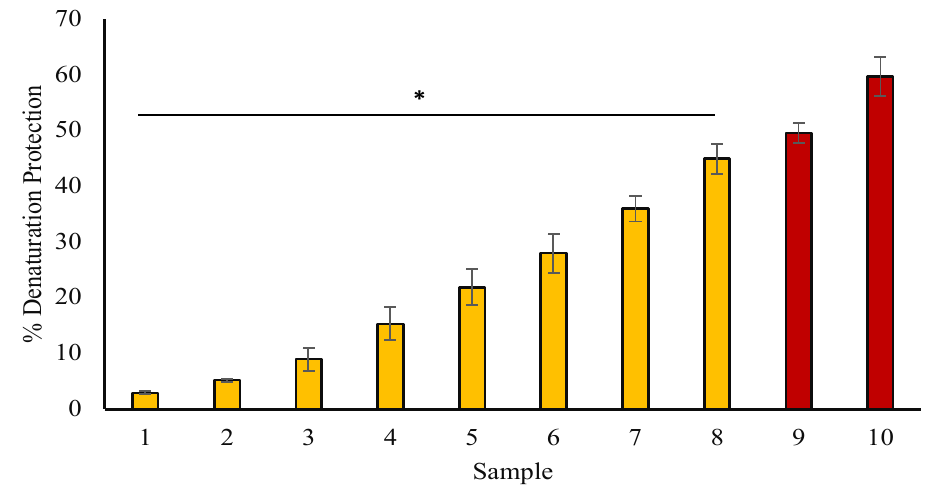
Figure 5. Egg albumin denaturation protection (%). Yellow columns (1–8) represent samples with various concentrations (50, 75, 100, 200, 300, 400, 500, and 600 µg/mL) of myrrh extract. The red columns (9 and 10) represent samples having 100 and 200 µg/mL concentrations of diclofenac, respectively. The data are shown as means ± standard error of the means (n = 3, p < 0.05). The statistical differences are represented with an asterisk (*) for myrrh denoting significance at p < 0.05 in comparison with the reference sample.